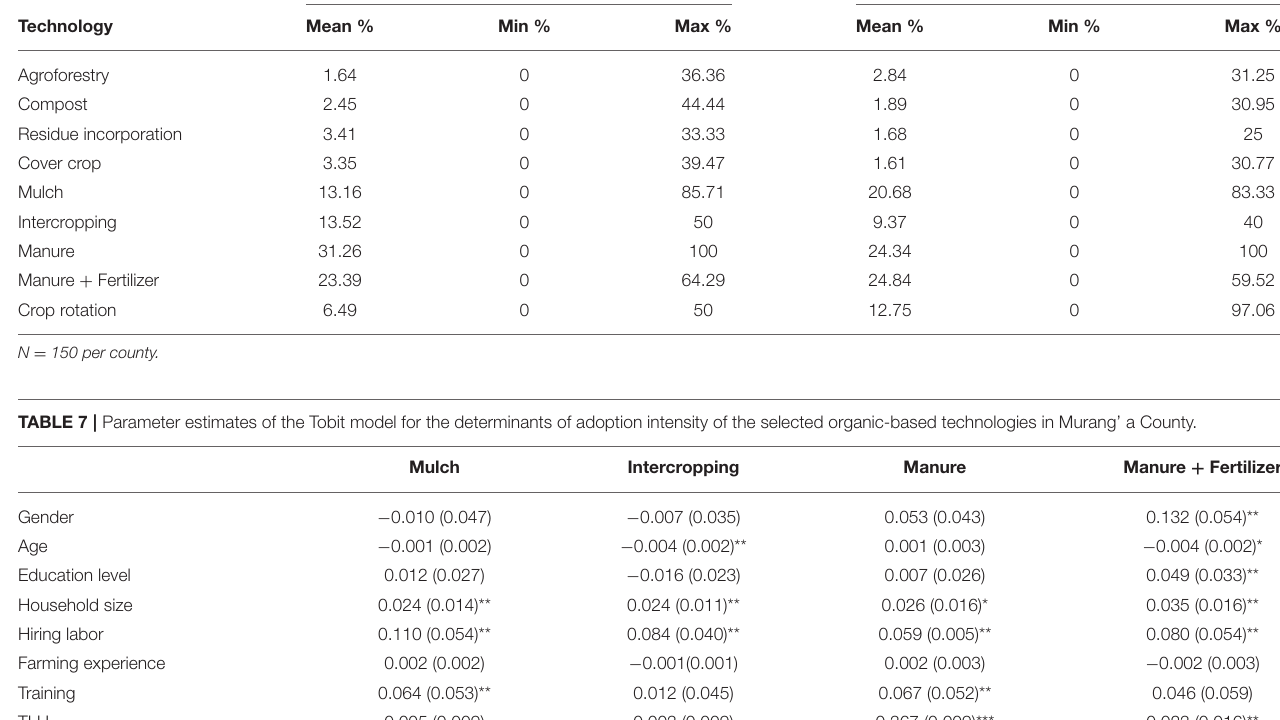
TABLE 6 | Minimum, maximum, and the average per cent of land under organic-based technologies in relationship to total cultivated land in Murang’ a and Tharaka-Nithi. Murang’a